Question: What does this figure show? Answer in one sentence.
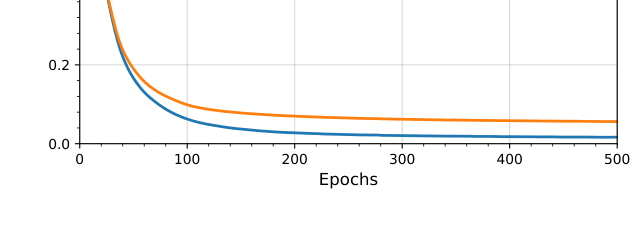
Answer: Training and testing NRMSE (loss) over the epochs of the gradient descent algorithm.